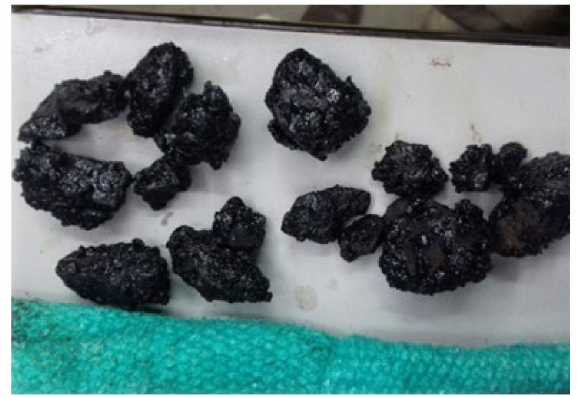
Figure 2. Detachment of the RCA asphaltic